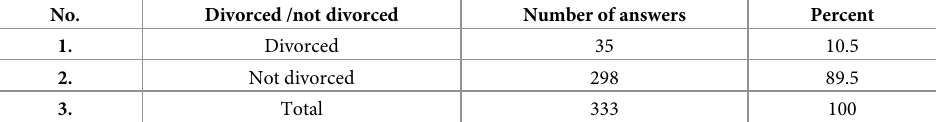
Table 5. Characteristics of the surveyed women with regard to their experience of divorce. N = 334 (no data avail- able for 1 mother). Source: Study by Ewa Krause. No.